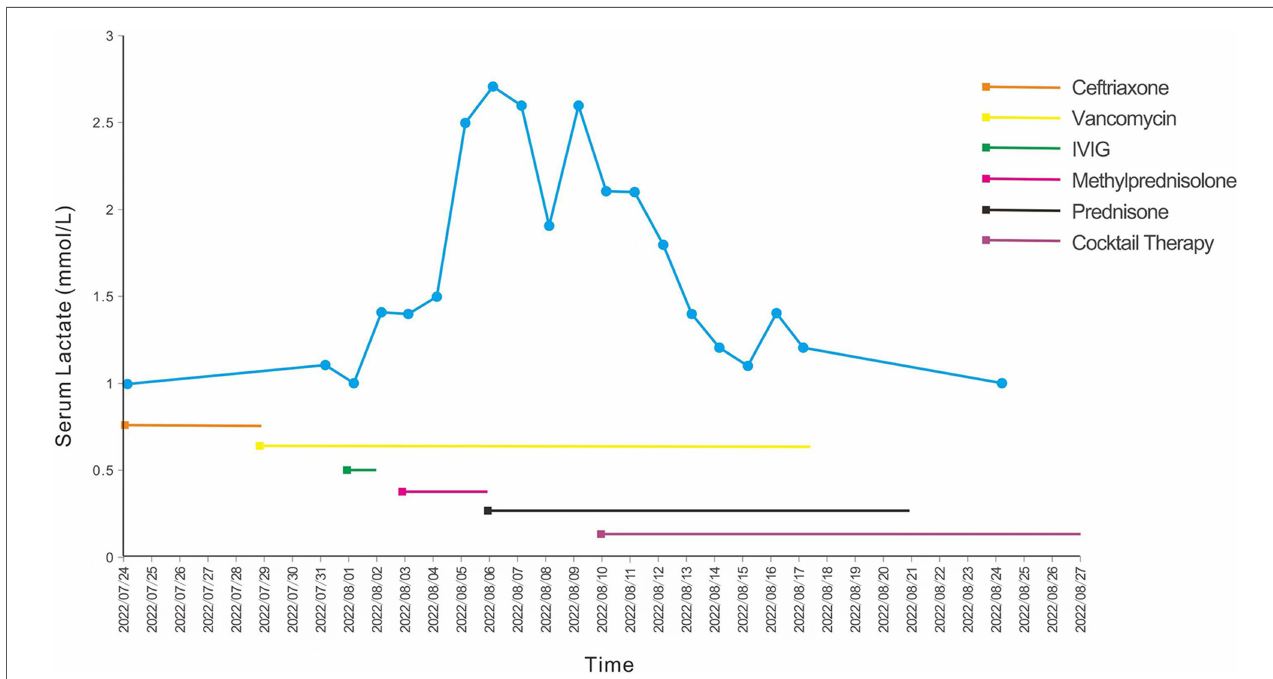
FIGURE 1 Blood lactate curve and treatment of the patient. The blue line represents the blood lactate levels of the patient after admission, and the straight lines with different colors represent different therapeutic drugs. IVIG, intravenous